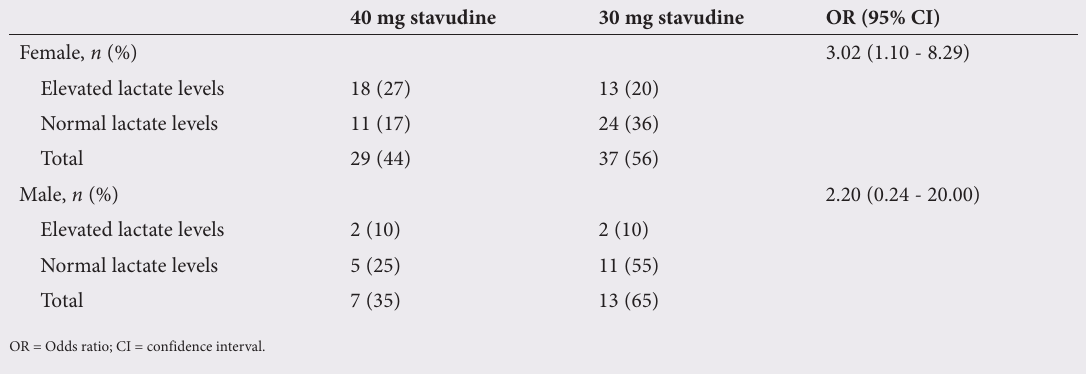
Table 1. Elevated lactate level in patients receiving 30 mg or 40 mg stavudine 40 mg stavudine Female, n